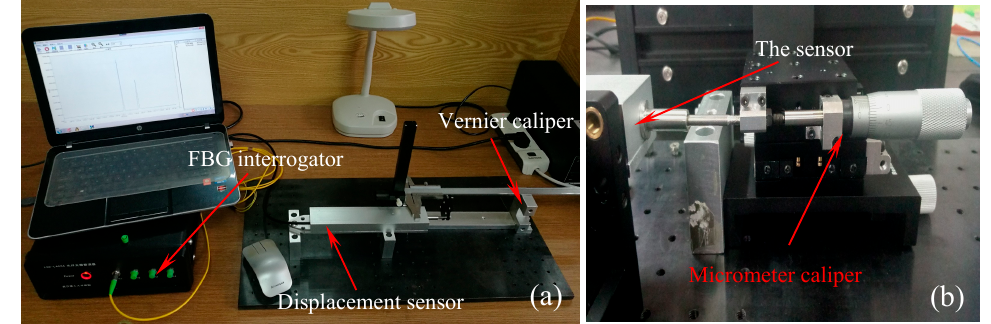
Figure 6. Photo of the experimental setup for displacement testing: ( a ) Large displacement measurement; ( b ) Micro-displacement measurement.